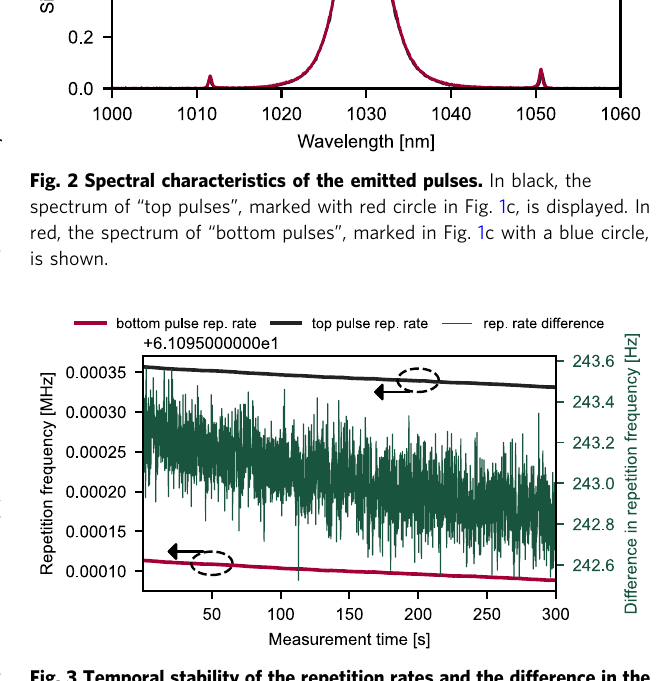
Fig. 3 Temporal stability of the repetition rates and the difference in the repetition rates. Both repetition frequencies monotonically decrease with time (black and red